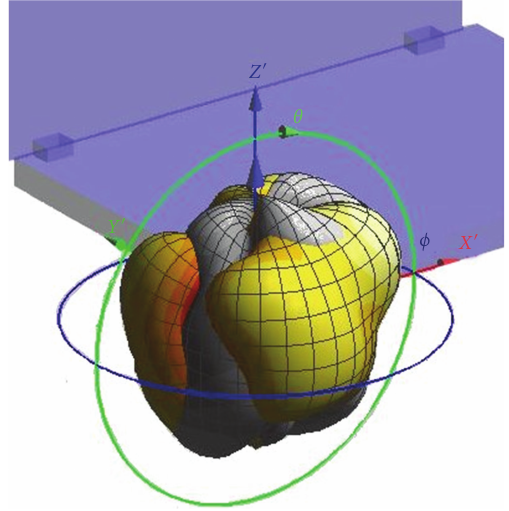
Figure 10: Compound pattern of a simulated datacard with 2 antennas in a laptop [6, 18]. The magnitude of the patterns are shown separately colored/black-and-white.